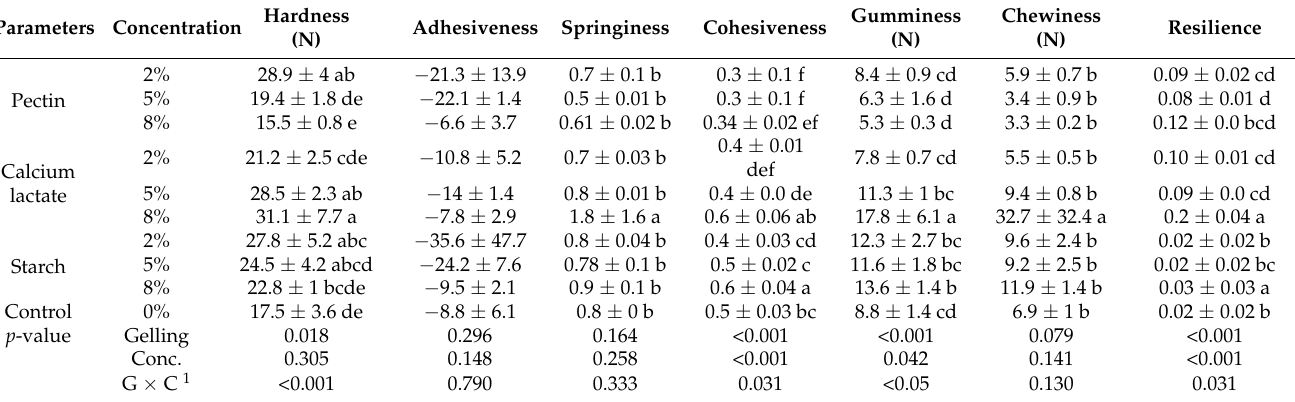
Table 1. Texture profile analysis of different gelling concentrations of gel-based